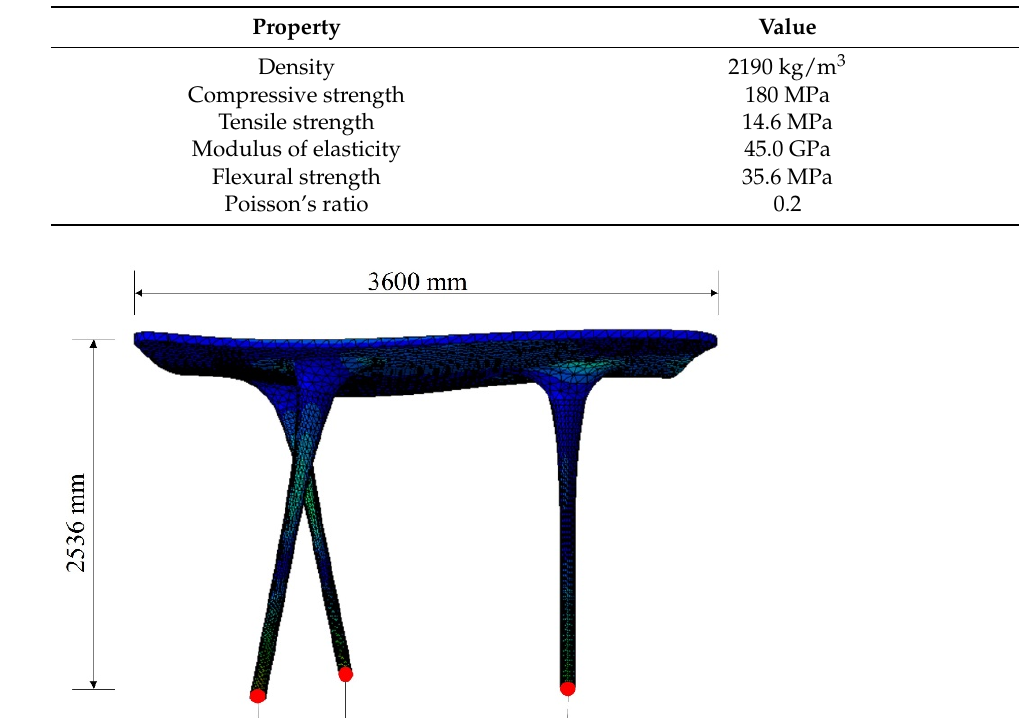
Table 8. UHPC material properties.